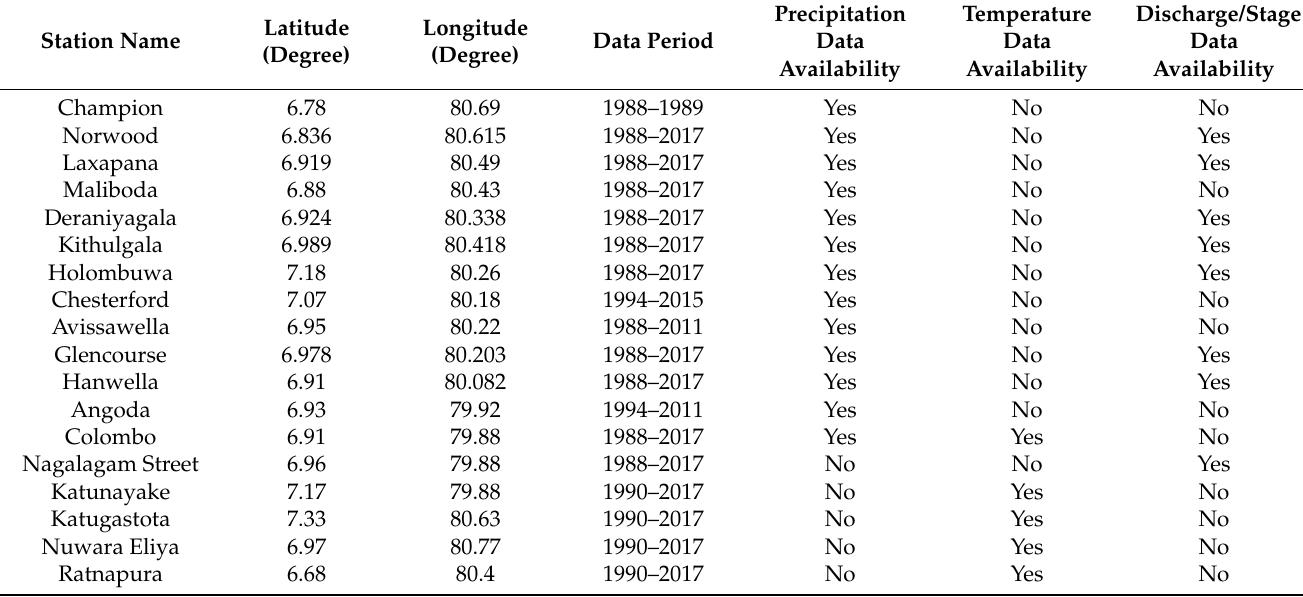
Table 1. Details of Hydro-Metrological